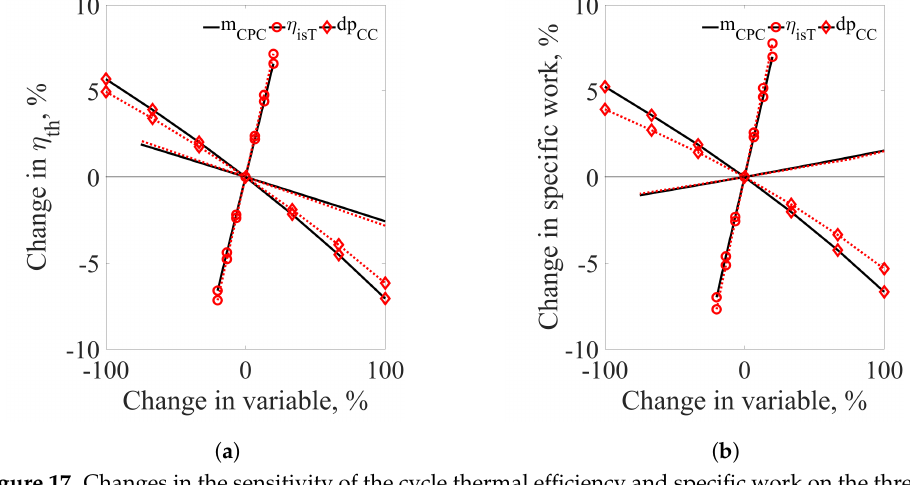
Figure 17. Changes in the sensitivity of the cycle thermal efficiency and specific work on the three cycle parameters presented in Table 4, due to a different pressure ratio value. TIT = 1700 ◦ C. The continuous lines refer to OPR = 10 and the dotted lines to OPR = 20. ( a ) Sensitivity of the cycle thermal efficiency; ( b ) Sensitivity of the cycle specific